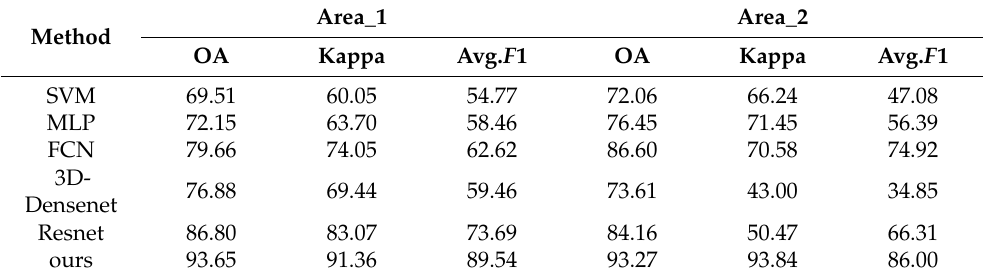
Table 4. Overall classification results of the compared methods.